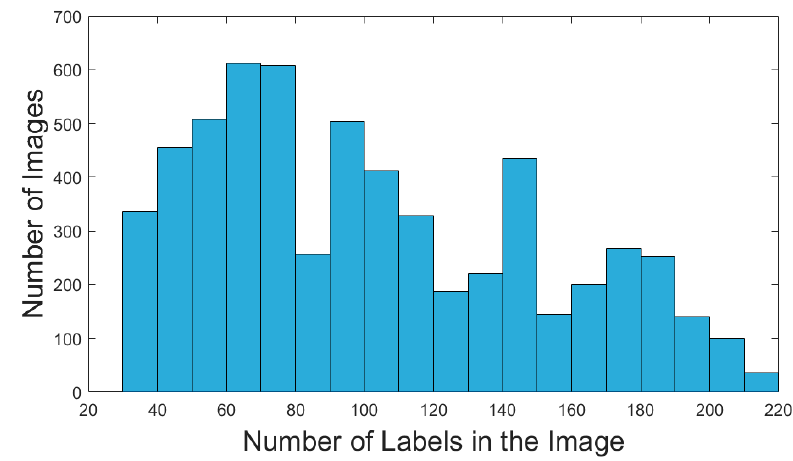
Figure 5. Histogram of the number of fish in the shoal of our dataset.